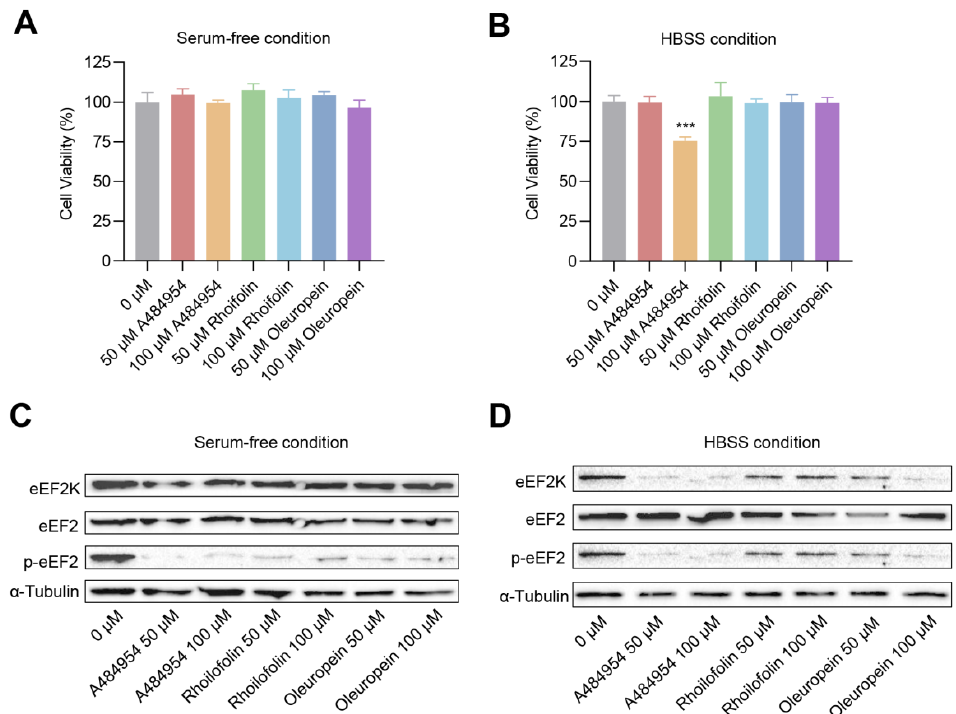
Figure 6. Effects of the selected compounds on cell viability and eEF2K activity. A484954 was used as a positive control. ( A , B ) CCK-8 assay of different concentrations of Rhoifolin and Oleuropein on Hela cells viability under serum-free condition ( A ) or HBSS condition ( B ), respectively ( n = 4). ( C , D ) Western blotting analysis of treatments of different concentrations of Rhoifolin and Oleuropein on indicated protein levels under serum-free condition ( C ) or HBSS condition ( D ), respectively.